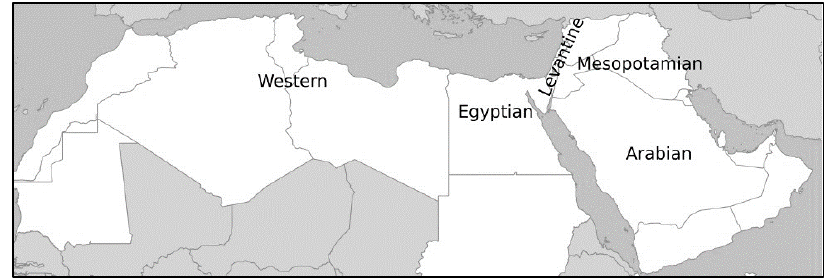
Figure 1 : A map representing the five main dialect groups of modern